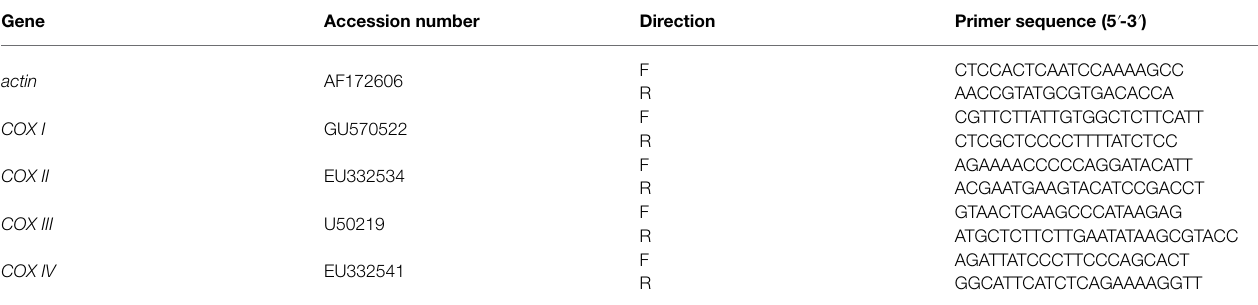
TABLE 2 | Sequences of the primers used in the